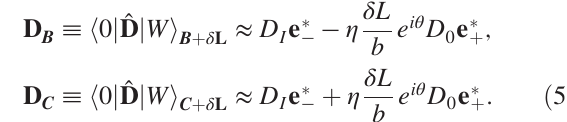
FIG. 2. Luminescence anomaly in the moir´e. (a) Degree of circular polarization P branch j 1 i , as a function of the wave packet central position in a moir´e supercell. P small neighborhood of B and C , where the rapid variation of P the emission polarization patterns near B and C , over a length scale of Δ b ∼ 0 . 01 b . (c) Degree of linear polarization P exciton wave packet trapped at B = C has a tiny displacement of δ L . (d) The optical dipole strength [in units of j D changes remarkably by δ L